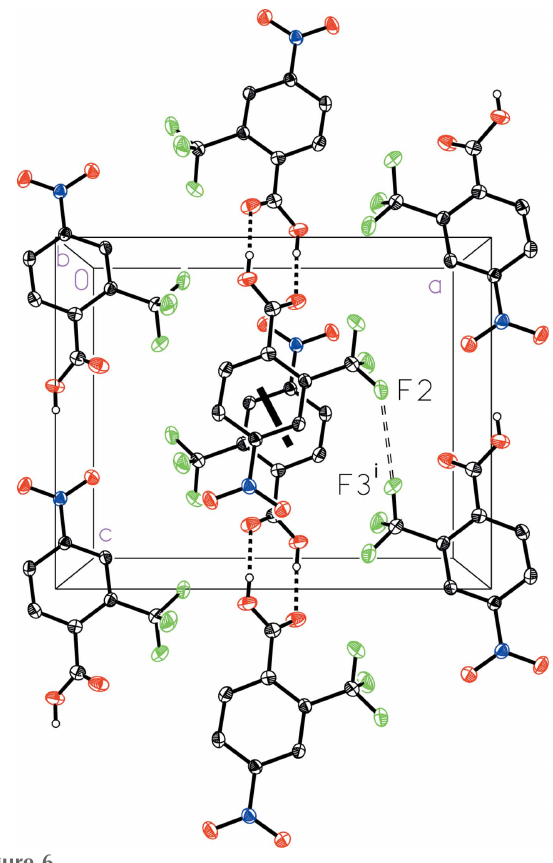
Figure 6 Aview of the packing in 4-nitro-2-(trifluoromethyl)benzoic acid (I) with a double-dashed line indicating the F (cid:4)(cid:4)(cid:4) F interaction and a thick solid line indicating a centroid-to-centroid interaction. [Symmetry code: (i) (cid:5) x + 3 y , z + 1 .] 2